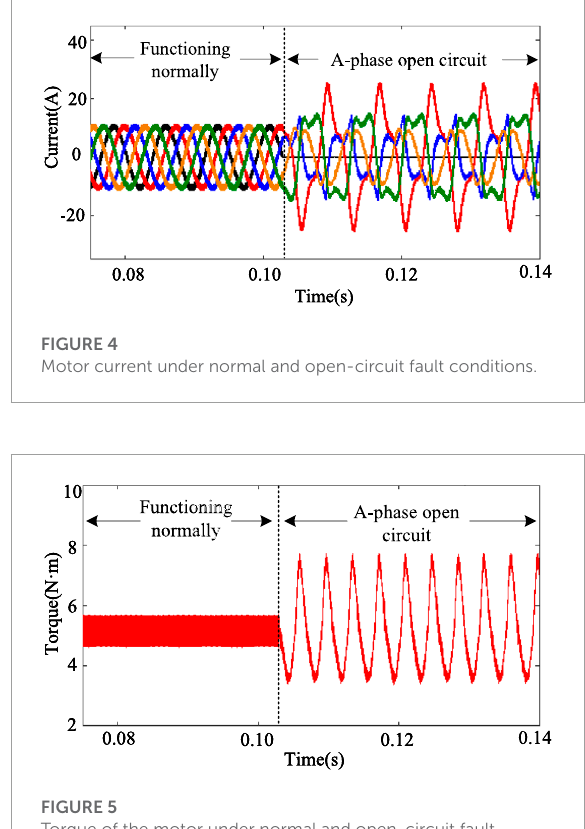
FIGURE 5 Torque of the motor under normal and open-circuit fault conditions.